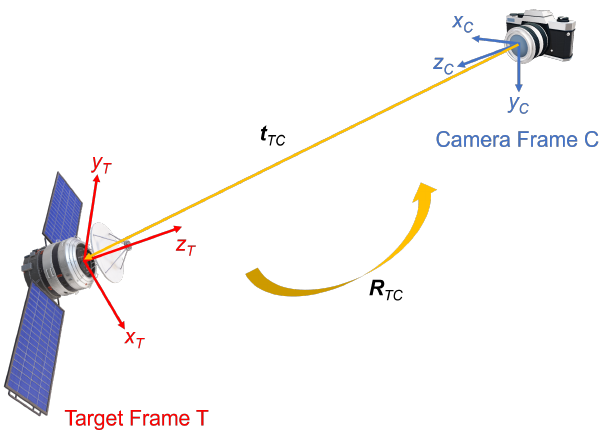
Figure 1. Definitions of the target reference frame (T), camera reference frame (C), relative position ( t TC ), and relative attitude ( R TC ).